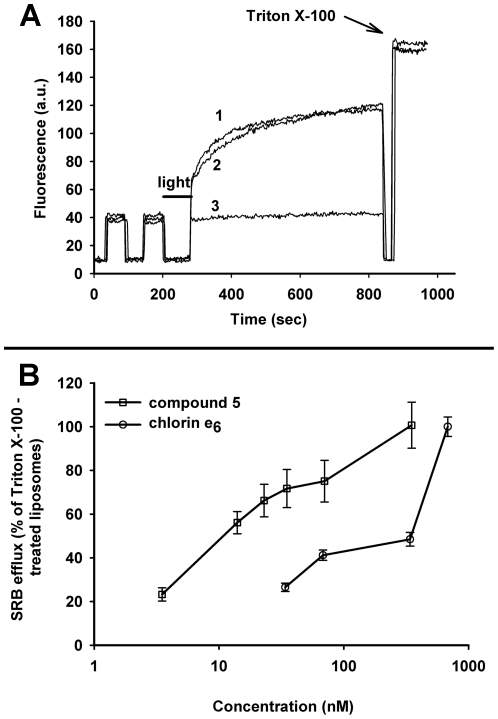
Time- and concentration dependence of liposome permeabilization.The SRB-loaded EggPC liposomes were suspended in PBS and illuminated in the presence of 35 nM of 5 (curve 1) or chlorin e6 (curve 2) (top panel; one representative experiment out of 4 with similar results). Bottom panel: dependence of SRB efflux (% at 100 s after LI) on indicated concentrations of each compound (bottom panel; mean ± S.D. of 3 experiments). Differences between the values of SRB efflux for the respective concentrations of compounds are statistically significant (p<0.01).